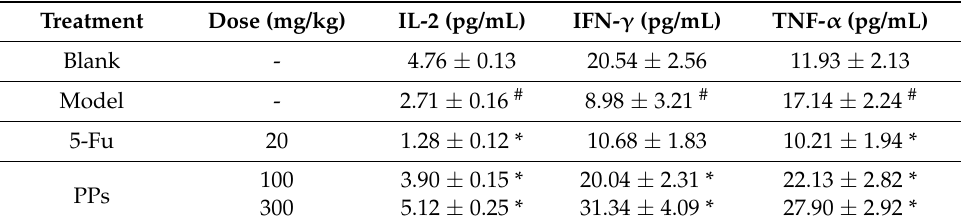
Table 2. Effect of PPs on the levels of IL-2, IFN- γ and TNF- α in serum of S180-bearing mice. Treatment Dose (mg/kg) IL-2 (pg/mL) IFN- γ (pg/mL) TNF- α (pg/mL) Blank -